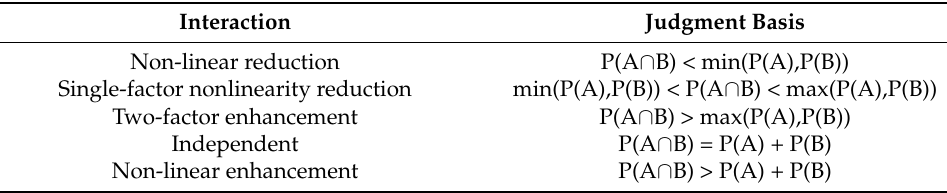
Table 2. The judgment basis of interaction mode.